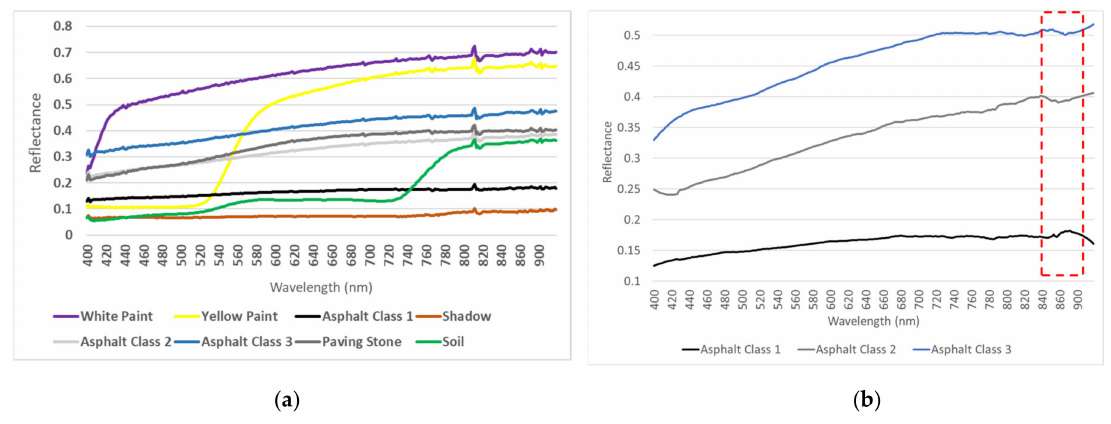
Figure 10. ( a ) Mean spectra for all classes. ( b ) Sample asphalt